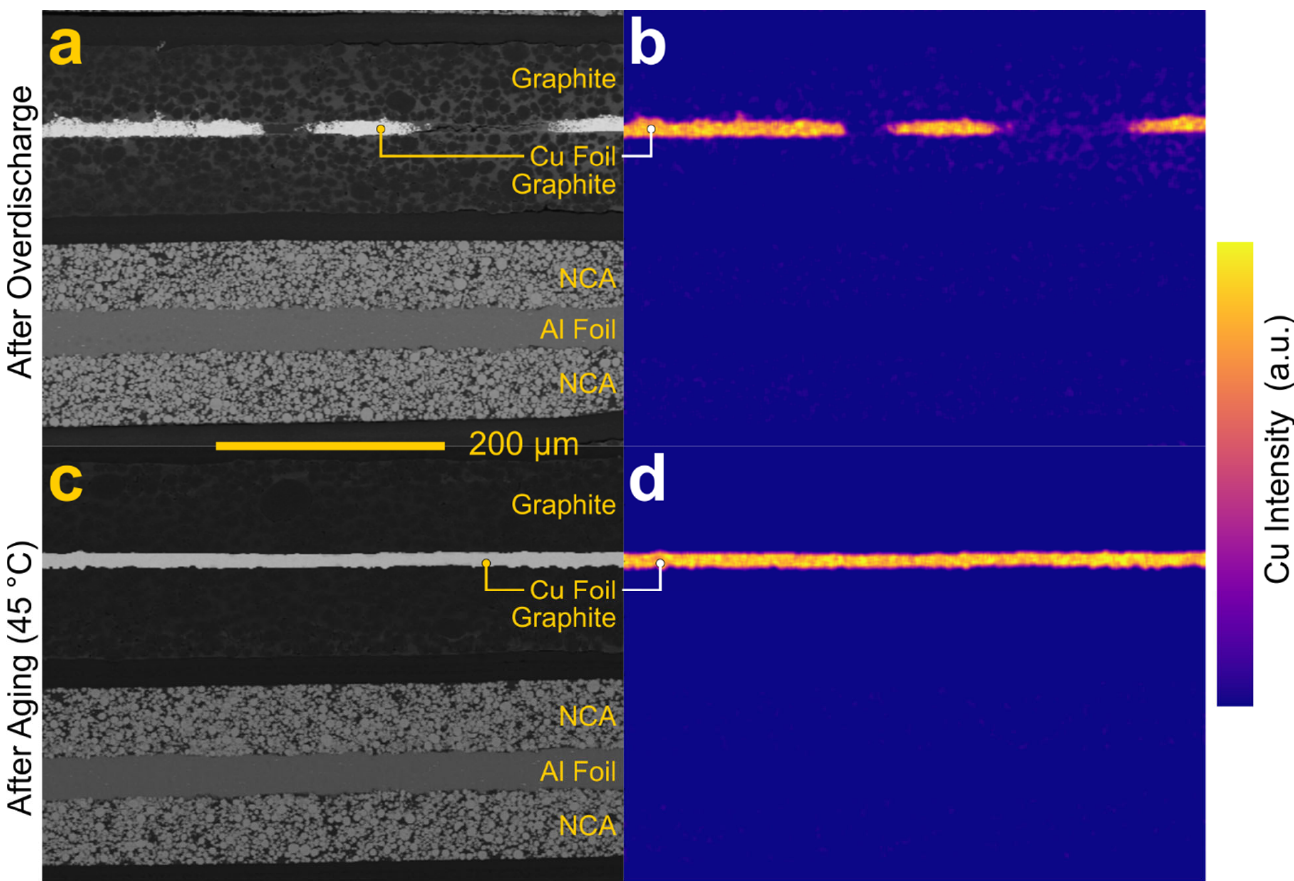
Figure 10. Backscatter ( a , c ) and Cu ‐ K EDS map ( b , d ) of the overdischarged ( a , b ) and aged ( c , d ) graphite cells. The color indicates the Cu ‐ K signal intensity. All images are scaled equally.